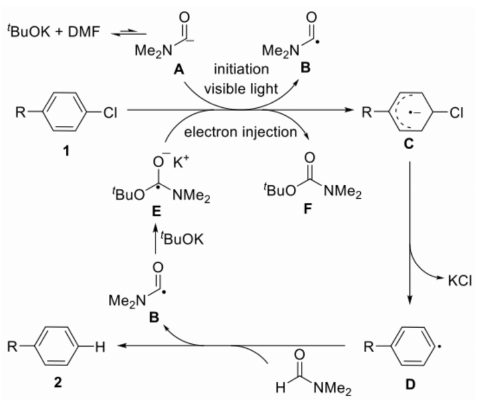
Figure 22. Proposed mechanism of visible-light-induced, base-promoted dehalogenation of aryl halides. Reprinted with permission from Ref. [78]. Copyright 2020, American Chemical